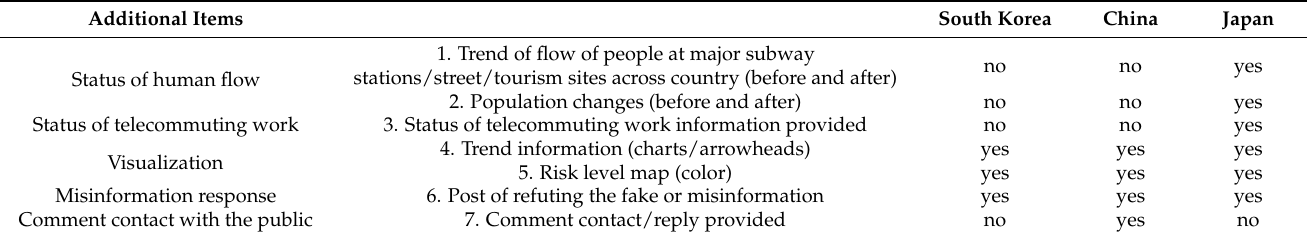
Table 5. Content comparison of “additional items” for the COVID-19 dashboard in South Korea, China, and Japan. Additional